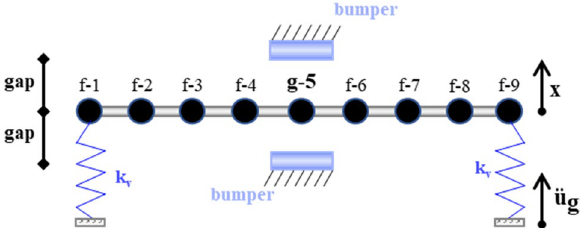
Figure 3. Single span (SS) discretized into 9 nodes that vibrate vertically and rotate; f indicates the nodes that do not experience the impact, whereas g-5 has a two-sided displacement